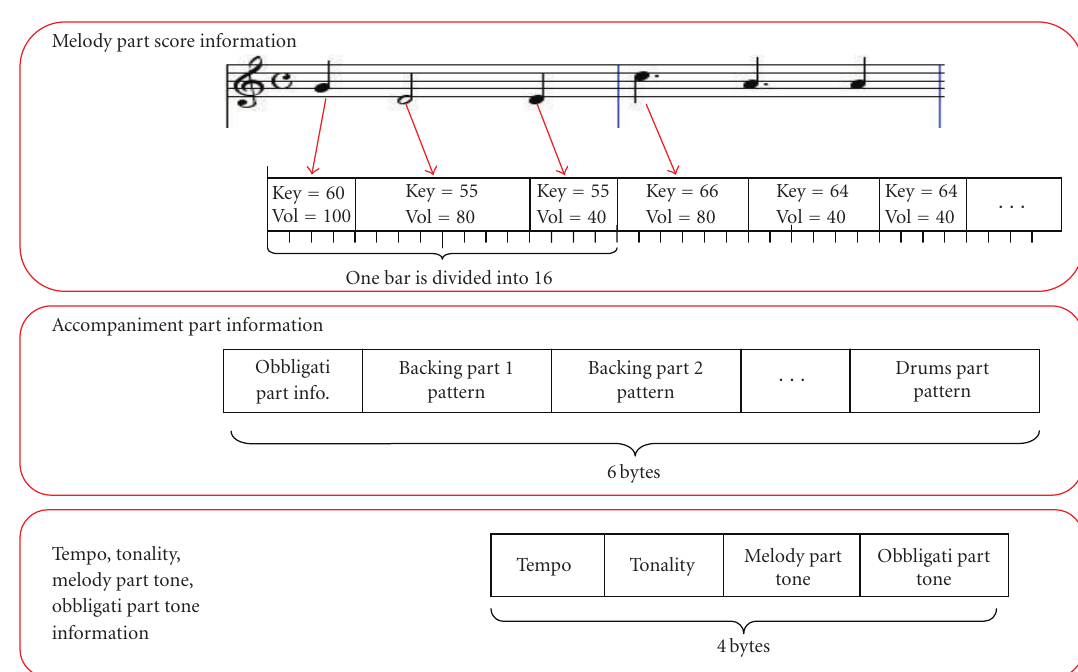
Figure 3: Three kinds of